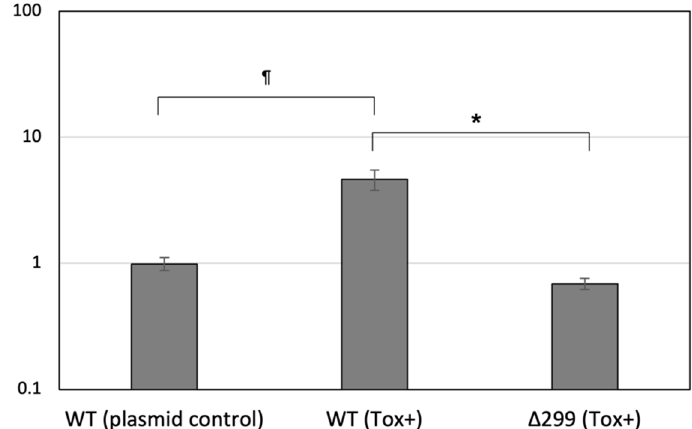
Figure 5. Effect of tox40 overexpression on persister formation. Cultures of WT strain and ∆ 299 mutant overexpressing the tox40 gene (Tox+) were treated with a lethal dose of ofloxacin to kill all nonpersisters. Cultures of WT harboring an empty plasmid were used as control. Aliquots of cells were withdrawn at the introduction of the antibiotic (T = 0) and after the 5-h antibiotic treatment. Cells were washed with PBS, serially diluted, and spot-plated onto THYE agar for CFU determination. The data (normalized to T = 0) are the average of three independent experiments ± standard error. ¶ denotes statistically significant difference compared to WT (plasmid control). * denotes statistically significant difference between Δ 299 (Tox+) vs. WT (Tox+).